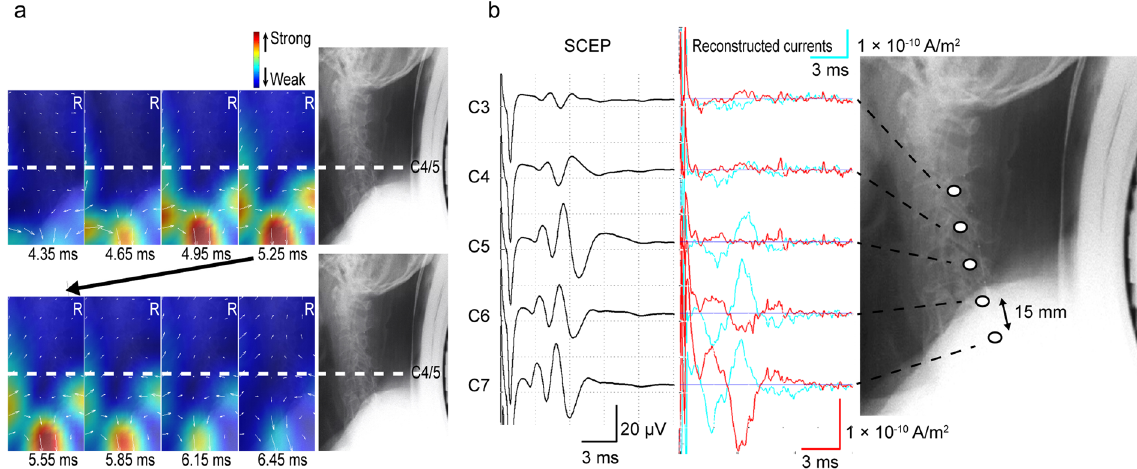
Figure 4. Reconstructed currents of the cervical spondylotic myelopathy patient. Currents are illustrated in a similar manner to Fig. 2. The current map is in the anterior–posterior direction, and the X-ray image of the lateral view shows the corresponding levels of the cervical spine. ( a ) In the reconstructed current map, the leading component is not illustrated because its intensity is much lower than that of other currents. When the perpendicular components stopped and disappeared caudal to C4/5, the trailing component simultaneously disappeared caudal to C5/6. ( b ) The left graphs are the ascending spinal cord evoked potentials (SCEPs) by stimulation of the lower thoracic cord showing conduction block at the C4/5 disc level. The right graphs are the reconstructed currents at the midline of the cervical spinal canal (red) and 2 cm lateral (blue). The leading component (the first waveform in red) attenuated and disappeared through C4–6, and the trailing component (the second waveform in red) disappeared at C5/6. The perpendicular inflow components greatly attenuated at C4/5 (the second waveform in blue).